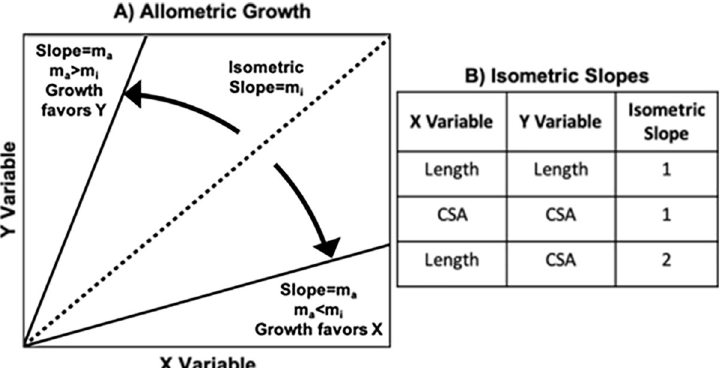
Fig 2. Allometric growth within or between tissues can be assessed by plotting data on a log-log graph (A) and comparing to the slope of an isometric line. Isometric slopes are listed for all possible combinations of CSA and length